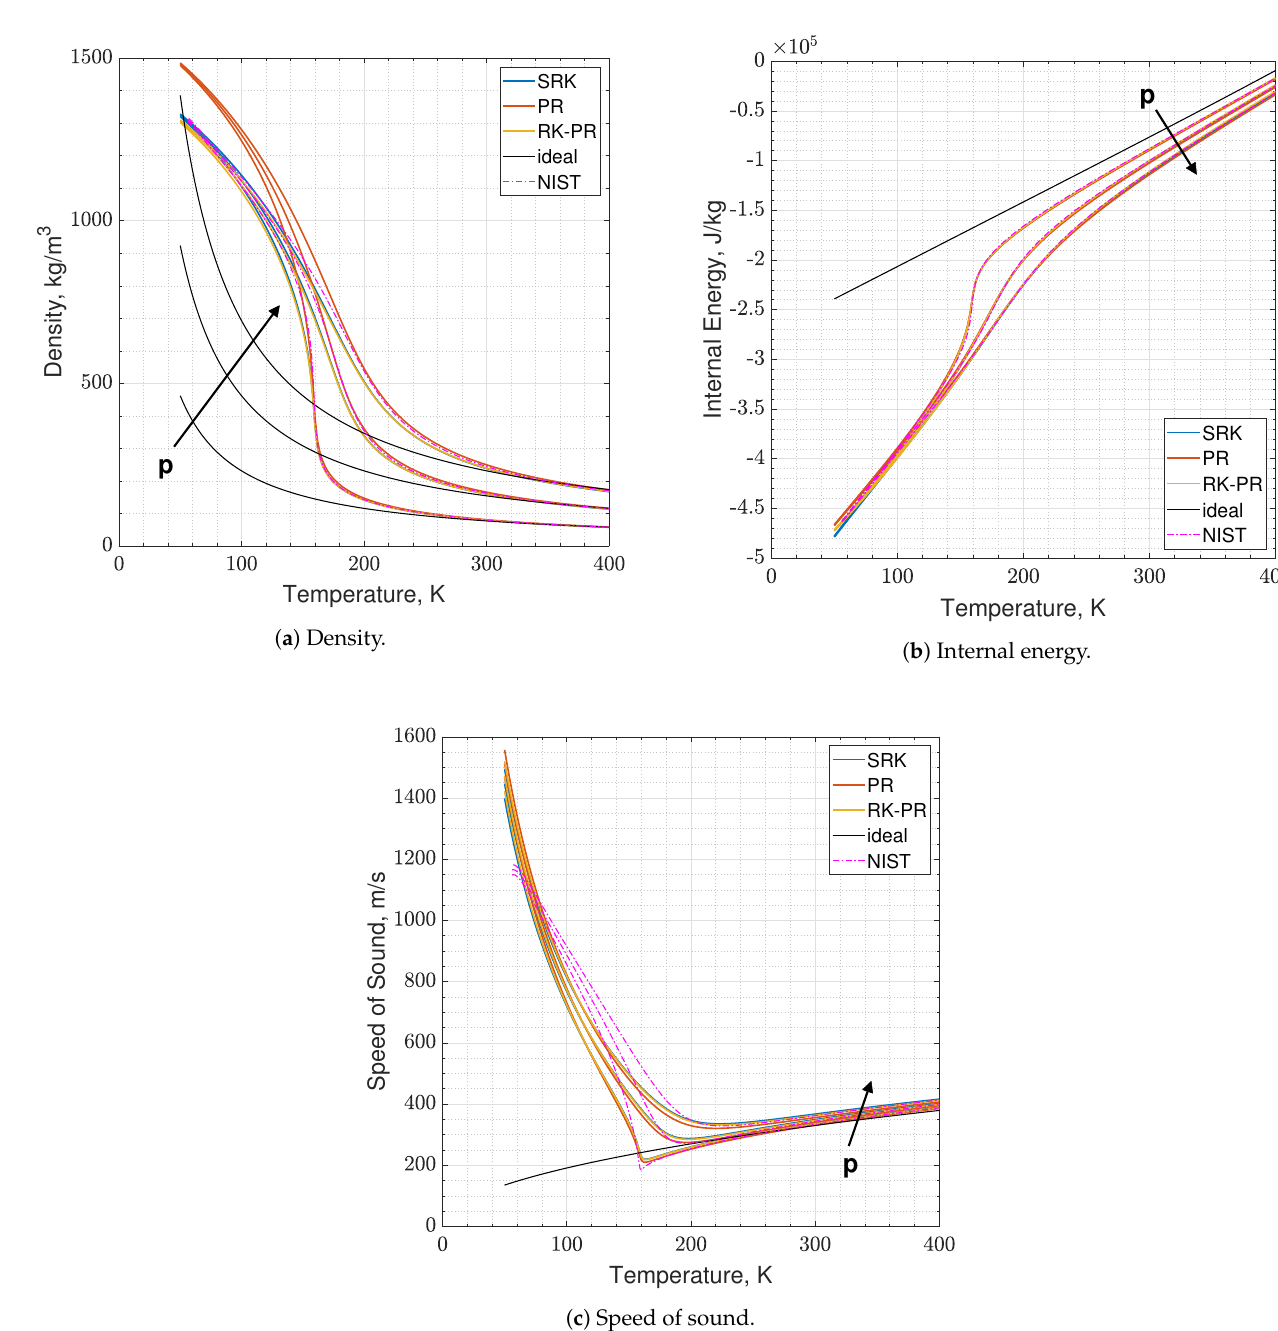
Figure 2. Comparison of the present EoS in its SRK, PR and RK-PR modes with refprop data and ideal behavior. Species is pure O 2 . Temperature range is 50–400 K. Pressure values are 6, 12 and 18